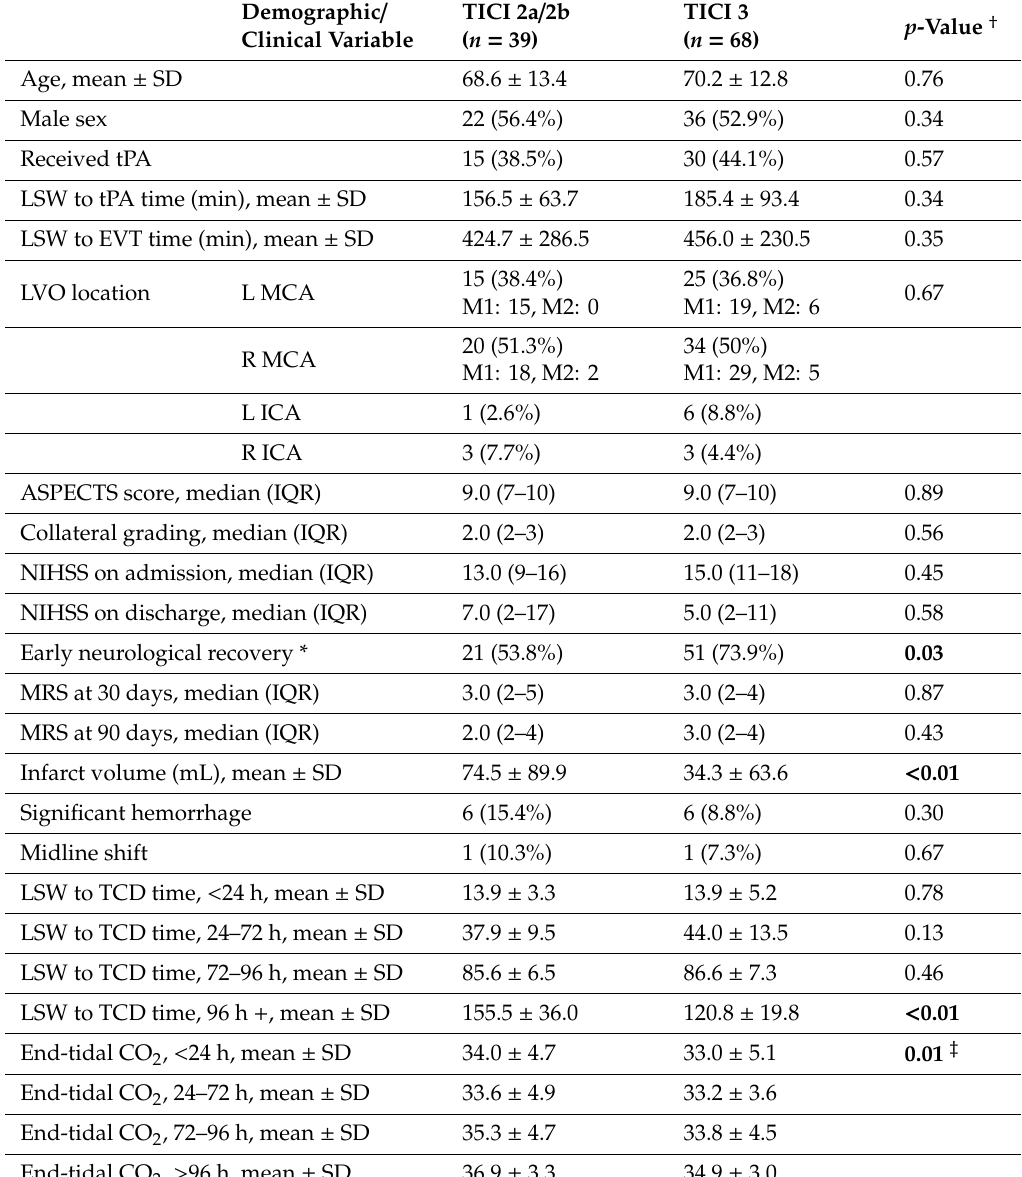
Table 1. Subject demographics and clinical